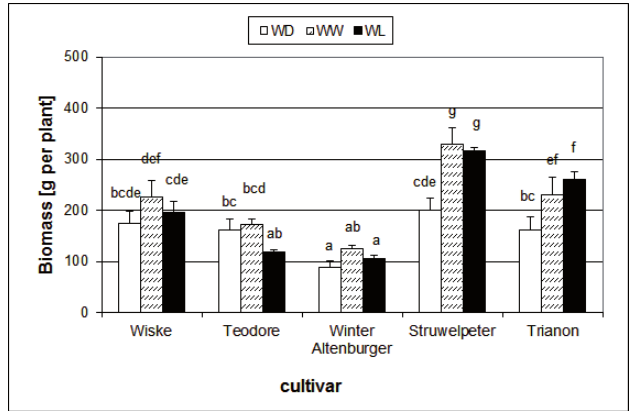
Fig. 1: Biomass [g per plant] of different cultivars and varieties of Lactuca sativa spp. grown under different water regimes (water-deficit = 18- 25 % [WD], well-watered = 50 % [WW], water-logged = 61-70 % [WL]). Data represent n ± SD. Bars with different letters were sig- nificantly different (Tukey-B test, p ≤